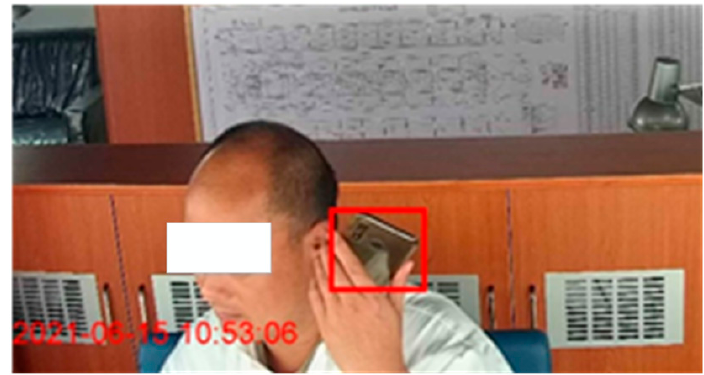
Figure 2. Real-time monitoring of the use of a cellphone.